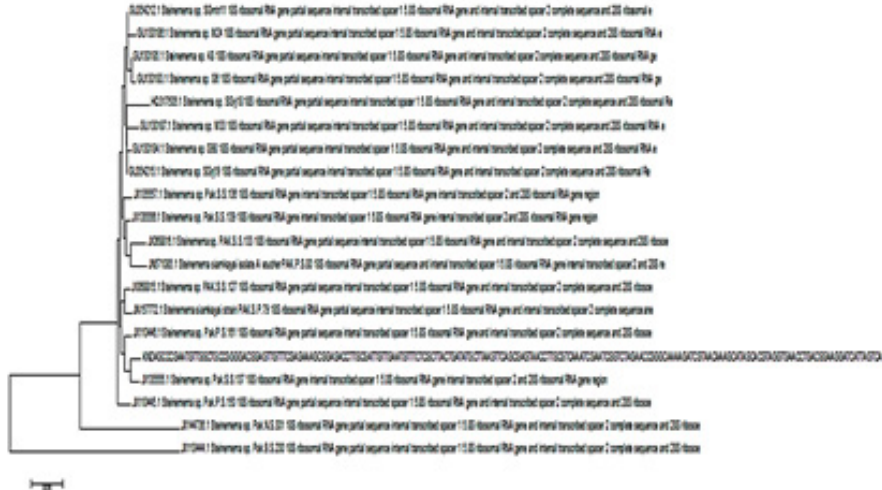
Fig. 2 Phylogenetic tree of Steinernema isolates found during the survey based on analysis of the ITS rDNA regions. The Phylogenetic analysis was performed by the neighbour-joining method with bootstrap analysis. Numbers indicated at the nodes represents bootstrap proportion values (50% or more, 1000 replications)